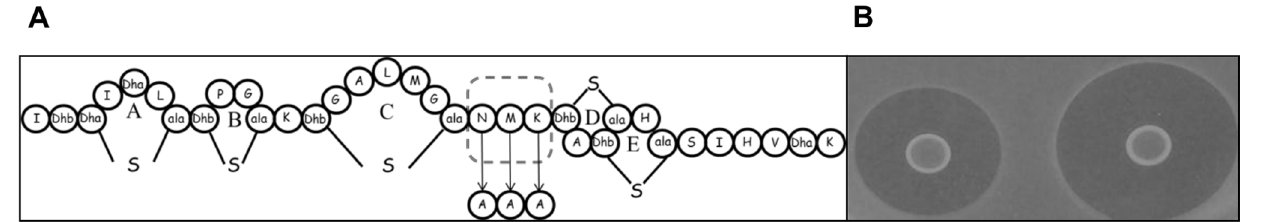
Figure 1. A - Nisin A mature peptide, B - AAA Producer (Deferred Antagonism Assay). The structure of the mature nisin A peptide and the zone of inhibition exhibited by the nisin A derivative, AAA. Panel A depicts the amino acid changes that produce the AAA derivative in the nisin ‘hinge’ region. The modified amino acids dehydroalanine and dehydrobutyrine are denoted as Dha and Dhb respectively with the five ( b - methyl)lanthionine rings labelled A to E. Panel B depicts the zones of inhibition produced by L. lactis NZ9800 pDF05(left) and AAA ‘hinge’ variant (right) against L. lactis HP.